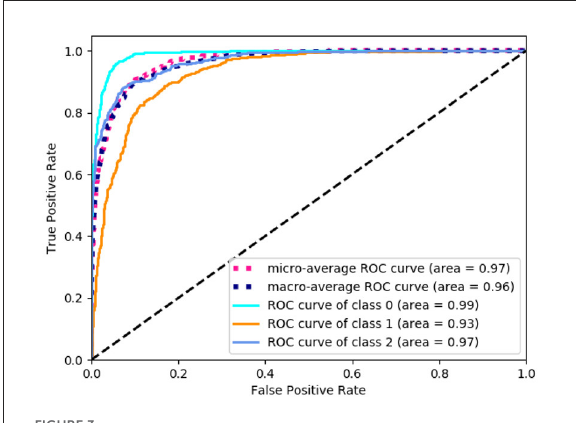
FIGURE3 The area under the curve (AUC) value of each balance level. The class 0, 1, and 2 correspond to low, medium and high balance levels